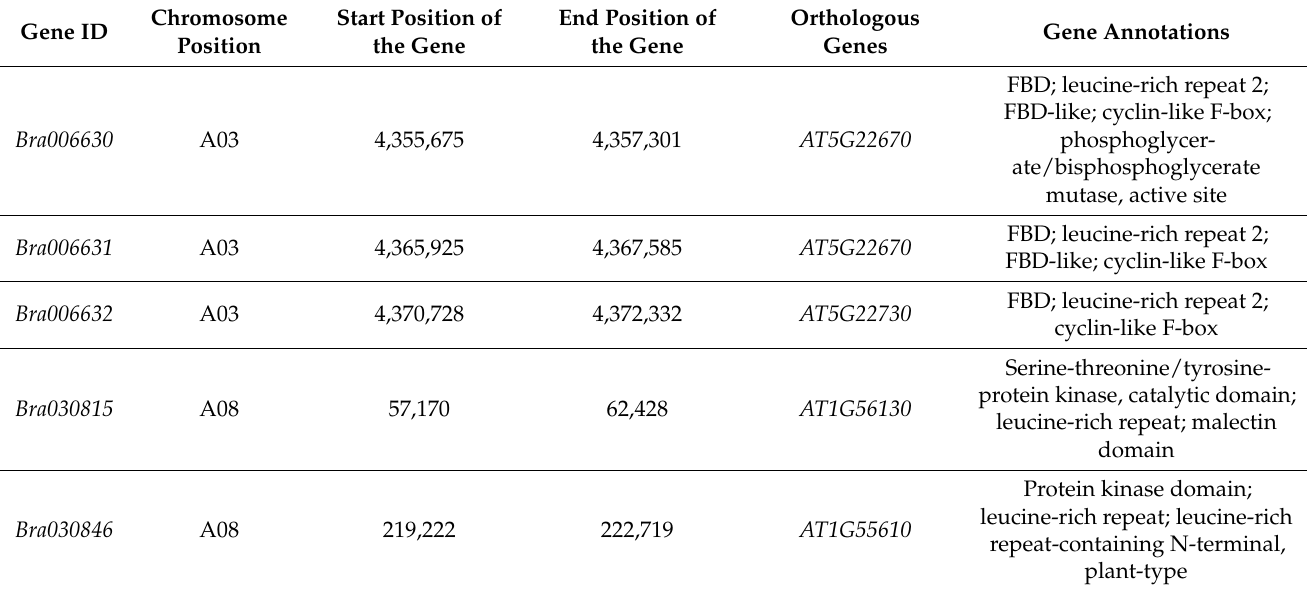
Figure 5. Identification and validation of CR QTL Bcr1 on chromosome A03. Table 3. Candidate R genes in candidate regions.